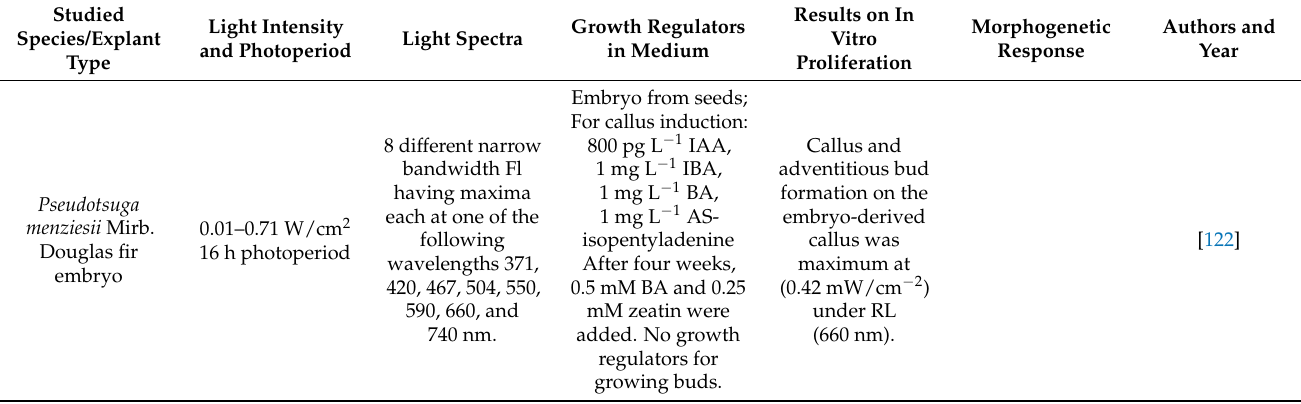
Table 2. Summary of the use of LED lighting in in vitro propagation of woody